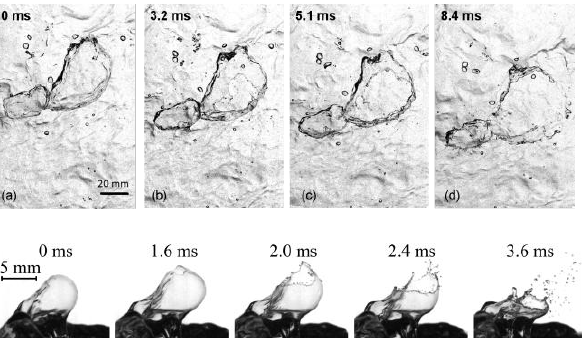
Fig. 3. The burst of a large bubble in strong wind conditions, U 10 =25 m/s. The top panel: (a) The floating bubble, t =0 ms. (b) Formation of a hole in the liquid film, t =3.2 ms. (c) Expansion of the hole, t =5.1 ms. (d) Droplet formation, t =8.4 ms. The bottom panel is the side view of the bubble burst.